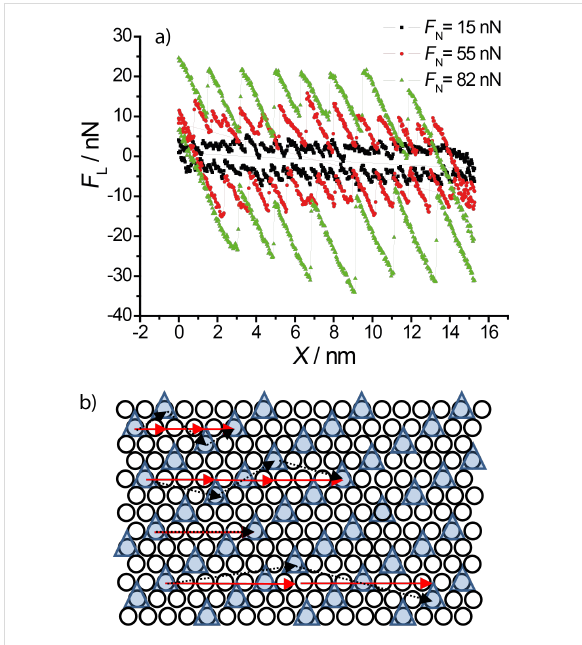
Figure 8: a) Typical cross sections from Figure 7 at F N = 15, 55 and 82 nN. b) Schematic illustration of the √ 7 × √ 3 structure of sulfate anions (triangles) on a copper monolayer (circles): arrows (black, dotted) denote a possible jumping pathway for the AFM tip in a single, double, triple and quadruple slip. (Of course, triangles may as well reflect minimal energy positions between the sulfate ions.)